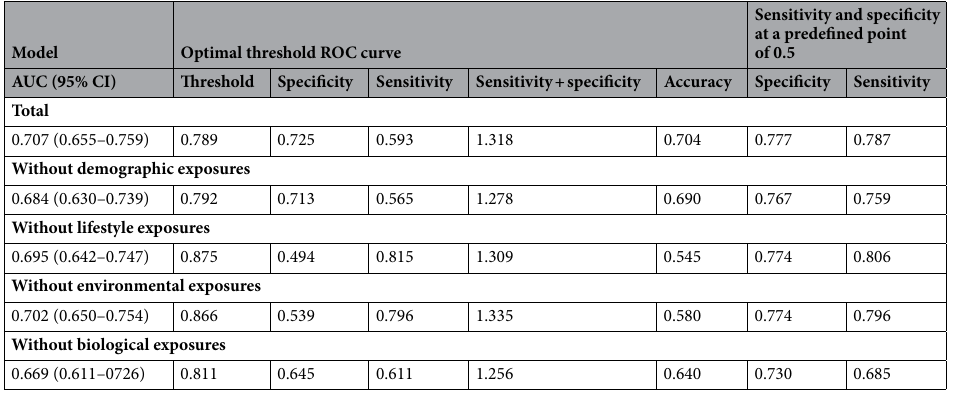
Table 3. Prediction performance metrics for the total model and the models without a particular domain of